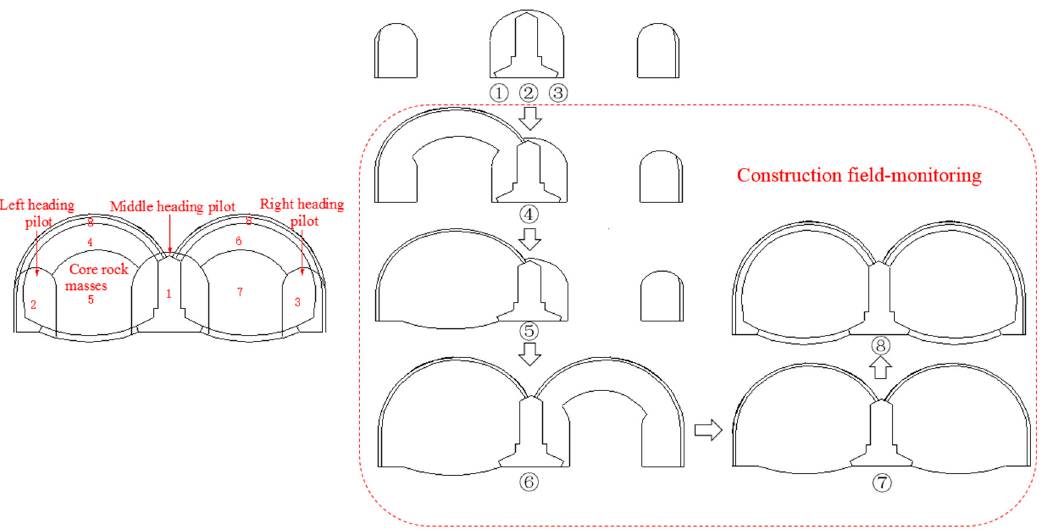
Figure 2. Schematic diagram of the three heading method in class IV and V rock masses.